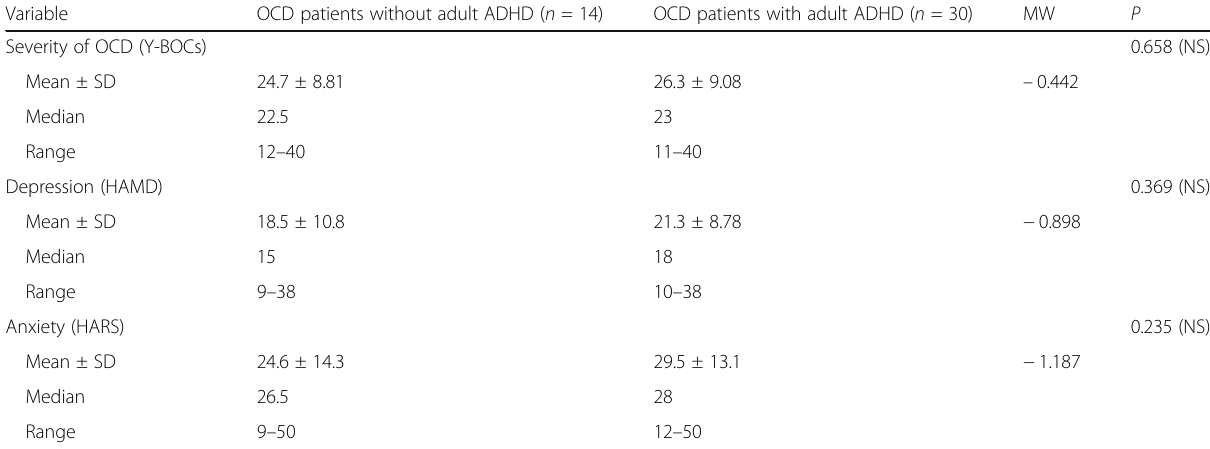
Table 2 Severity of OCD, depression, and anxiety among those with and without adult ADHD Variable